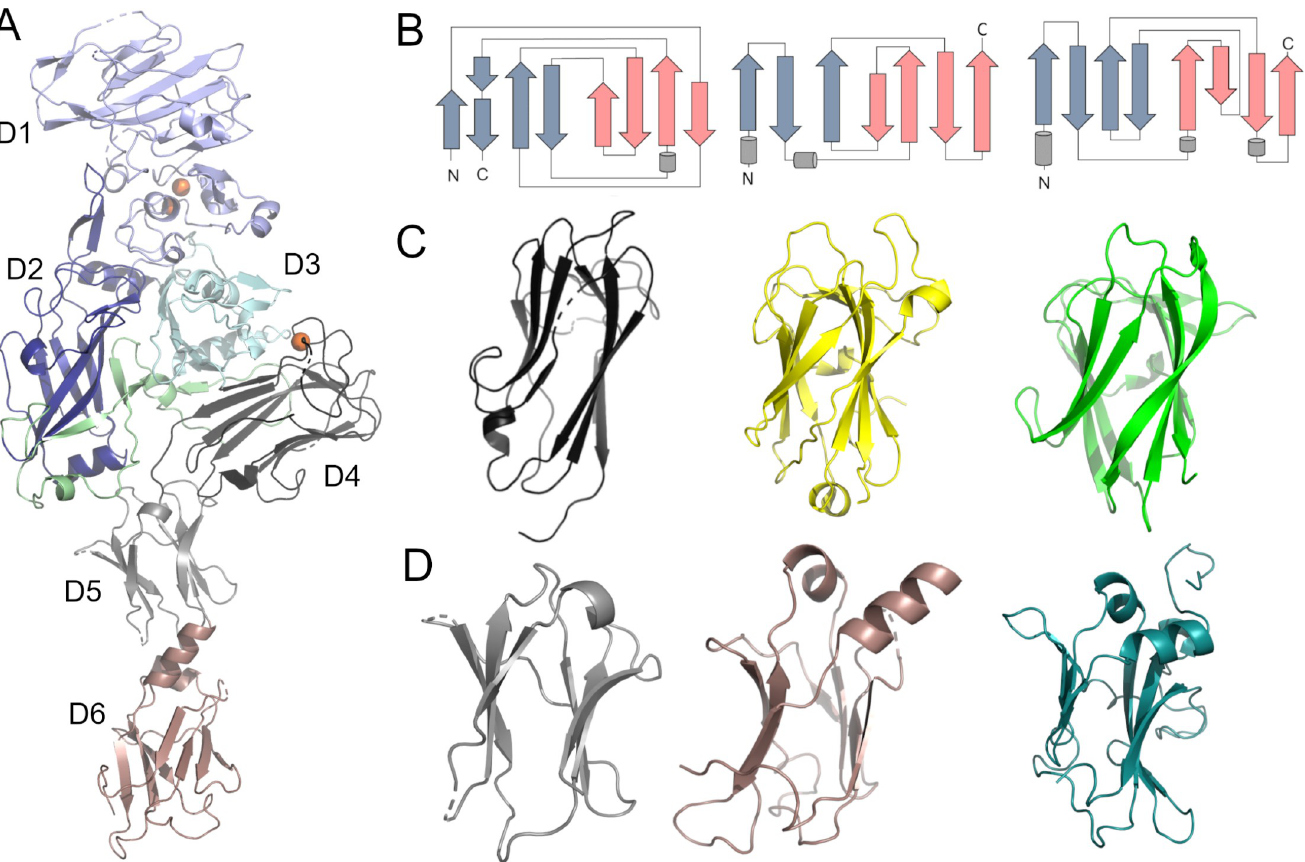
Fig 1. Bacillus thuringiensis Vpb4Da2 crystal structure. (A) Crystal structure of Vpb4Da2 structure and domains labeled D1 to D6. Predicted pore-forming loop is in pale green and calcium ions are orange spheres. (B) Topology diagrams of Vpb4Da2 domain 4 (left) and domain 6 (center) versus PA domain 4 from PDB ID Acc1 (right). (C) Vpb4Da2 domain 4 (left) versus Cry3Bb1 domain 3 from PDB ID 1ji6 (center) and Clostridium thermocellum xylanase carbohydrate binding module from PDB ID 1gmm (right). (D) Vpb4Da2 domains 5 (left) and 6 (center) versus PA domain 4 (right).